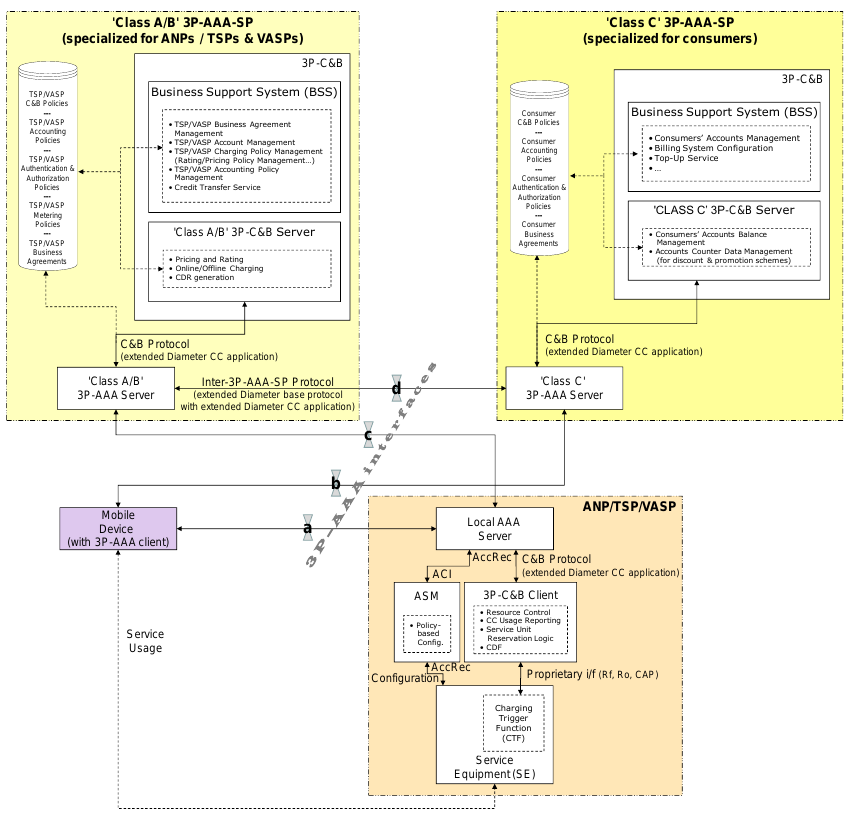
Figure 7. The generic 3P-C&B architecture, utilizing the credit-control (CC) concept [20] (an up- date from [15]).